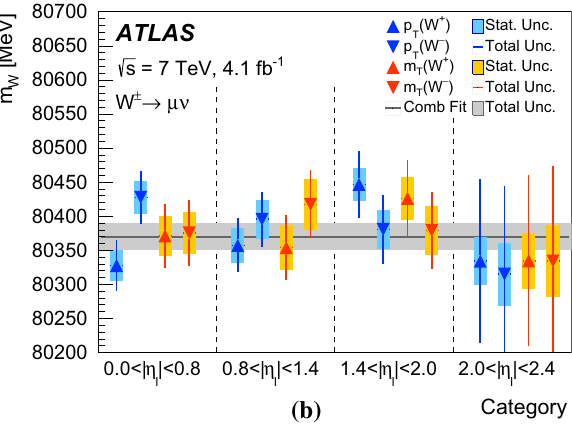
coloured bands and solid lines show the statistical and total uncertain- and m T distri- ties, respectively. The horizontal line and band show the fully combined T result and its